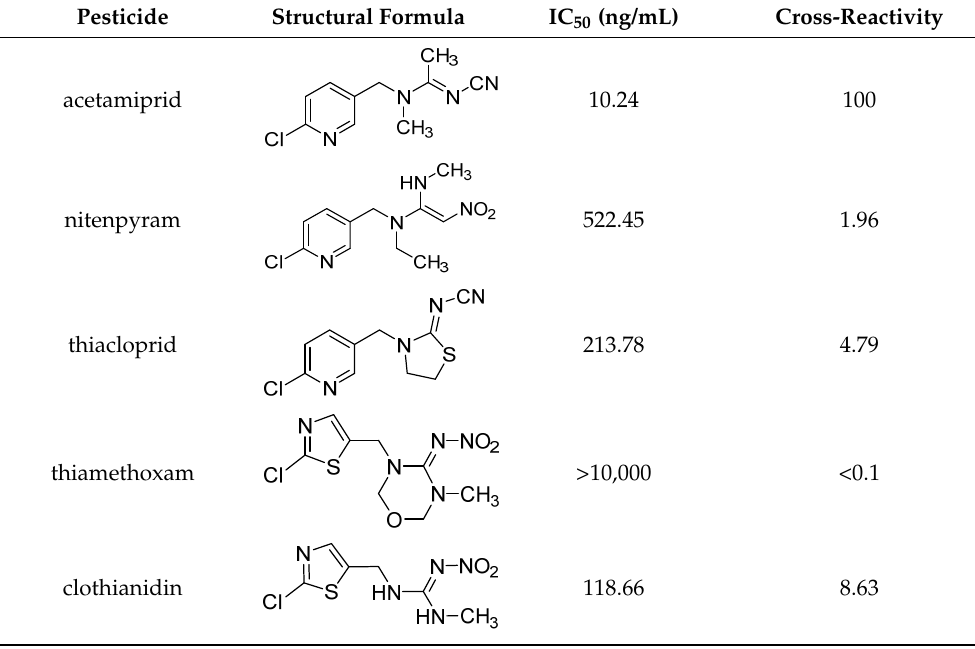
Table 1. Cross-reactivity of ACE and its analogues with anti-ACE mAb determined by ic-CLIEA ( n = 3).